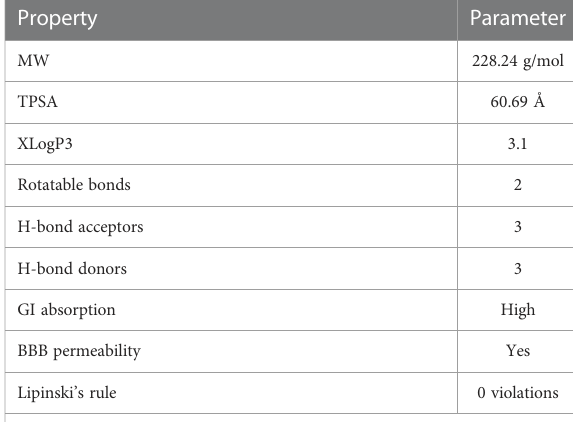
TABLE 1 The molecular parameters of RSV.